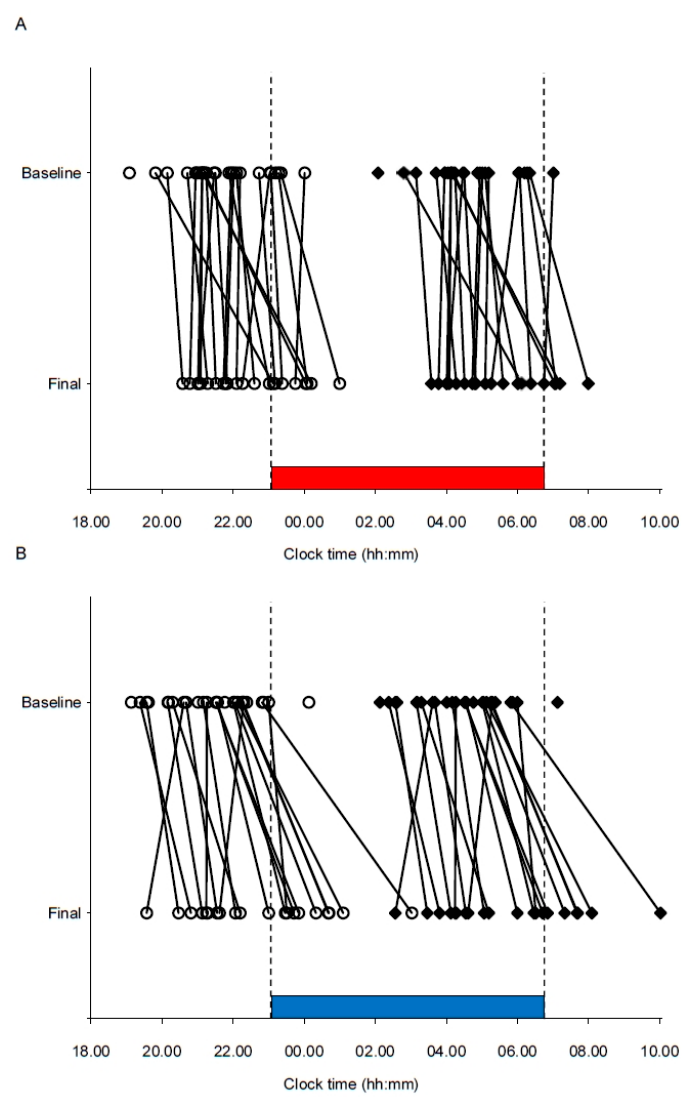
Figure 5. Phase markers for individual participants before (Baseline) and after (Final) a simulated night shift in ( A ) long-wavelength narrow-bandwidth light and ( B ) short-wavelength narrow-bandwidth light. Open circles indicate salivary dim light melatonin onset (DLMO) for each participant. Filled diamond squares indicate estimated temperature minimum (DLMO + 7 h) for each participant. Lines are drawn between the baseline and final markers for each participant. The vertical dotted lines and colored bars indicate the start and end times of the night shift and light exposure (23:00–06:45 h).